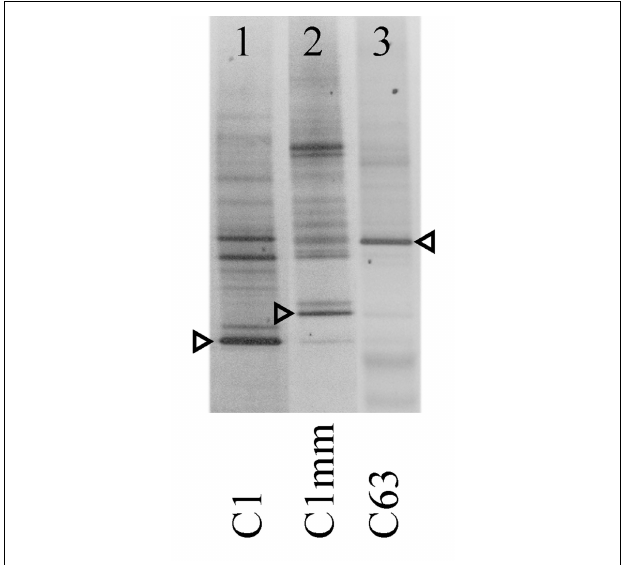
FIGURE 3 | Negative image of novel Symbiodinium ITS2 DGGE profiles from selected coral samples. Arrows indicate excised and sequenced bands. Designated symbiont types are indicated at the bottom of the